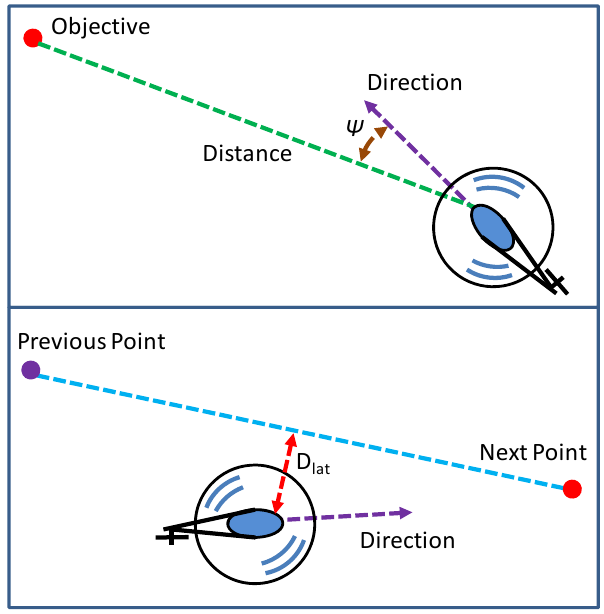
Figure 12. The concept diagram of the lateral controller of the guidance